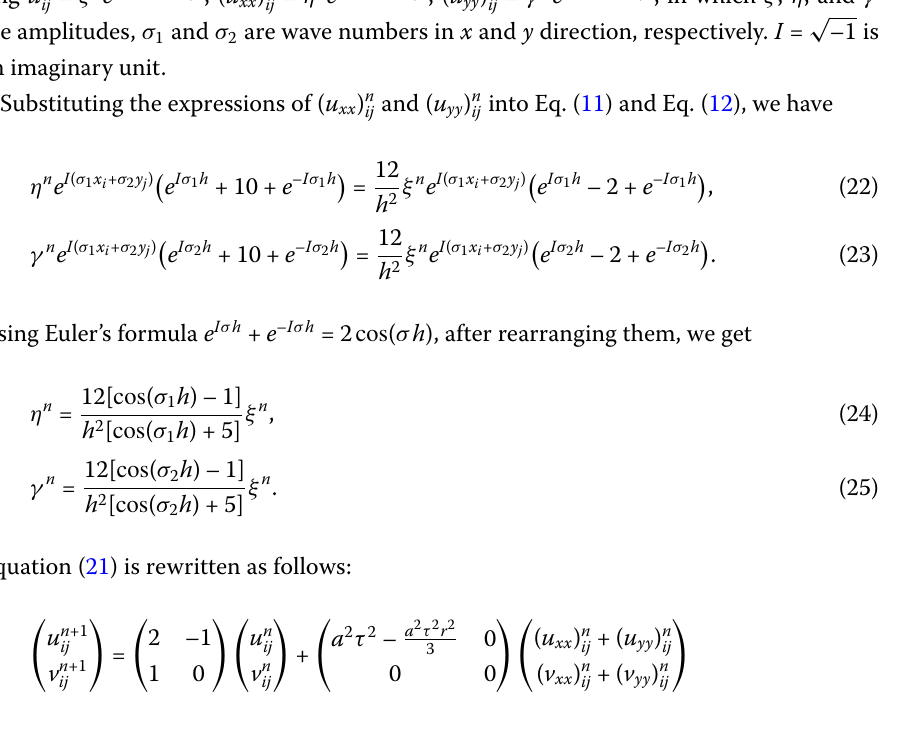
algorithm for solving wave equation (1) with initial and boundary conditions (2)–(5) as